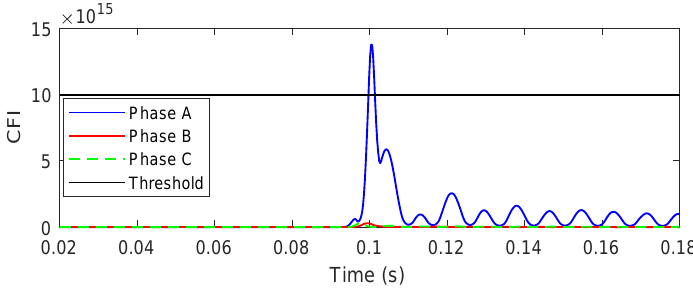
Figure 11. Combined fault index with AG fault on node 634 of test